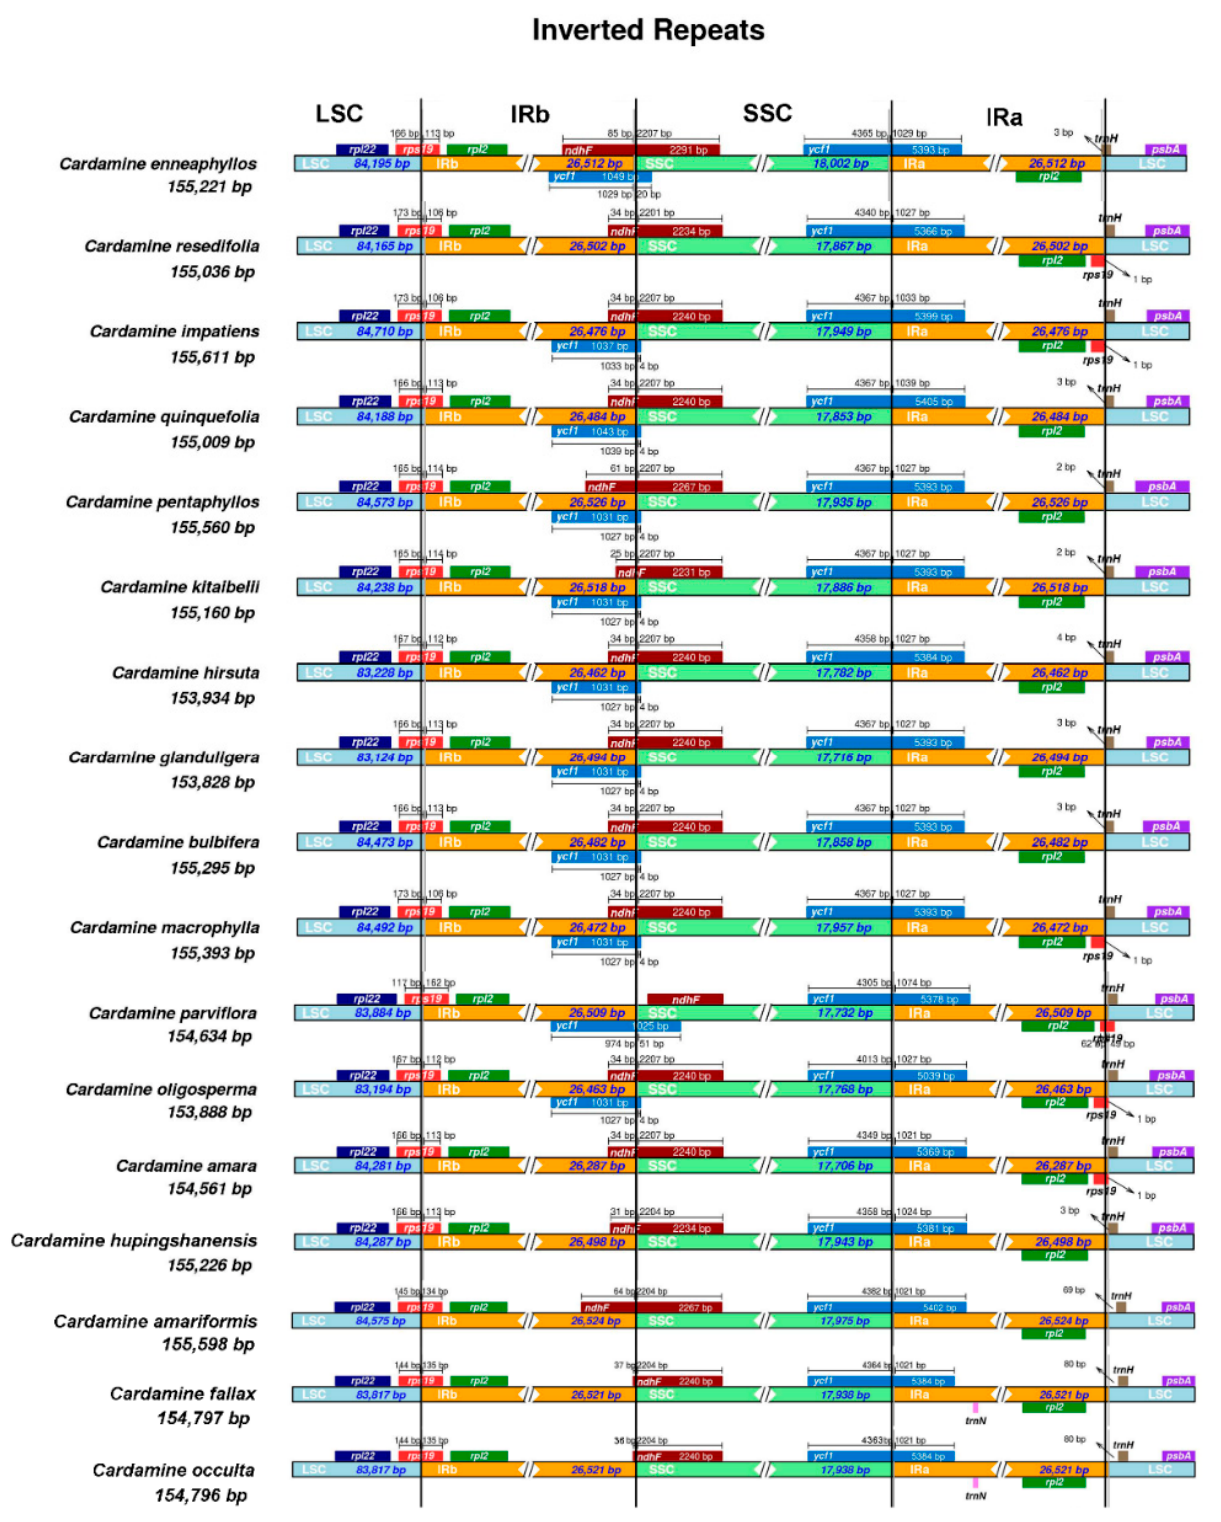
Figure 4. Comparison of the LSC/IRa/SSC/IRb junction among the chloroplast genomes of 17 Cardamine species. Colored boxes represent the adjacent border genes. Number above the gene indicates the distance in bp between the ends of genes and the junction sites. The features are not in scale.